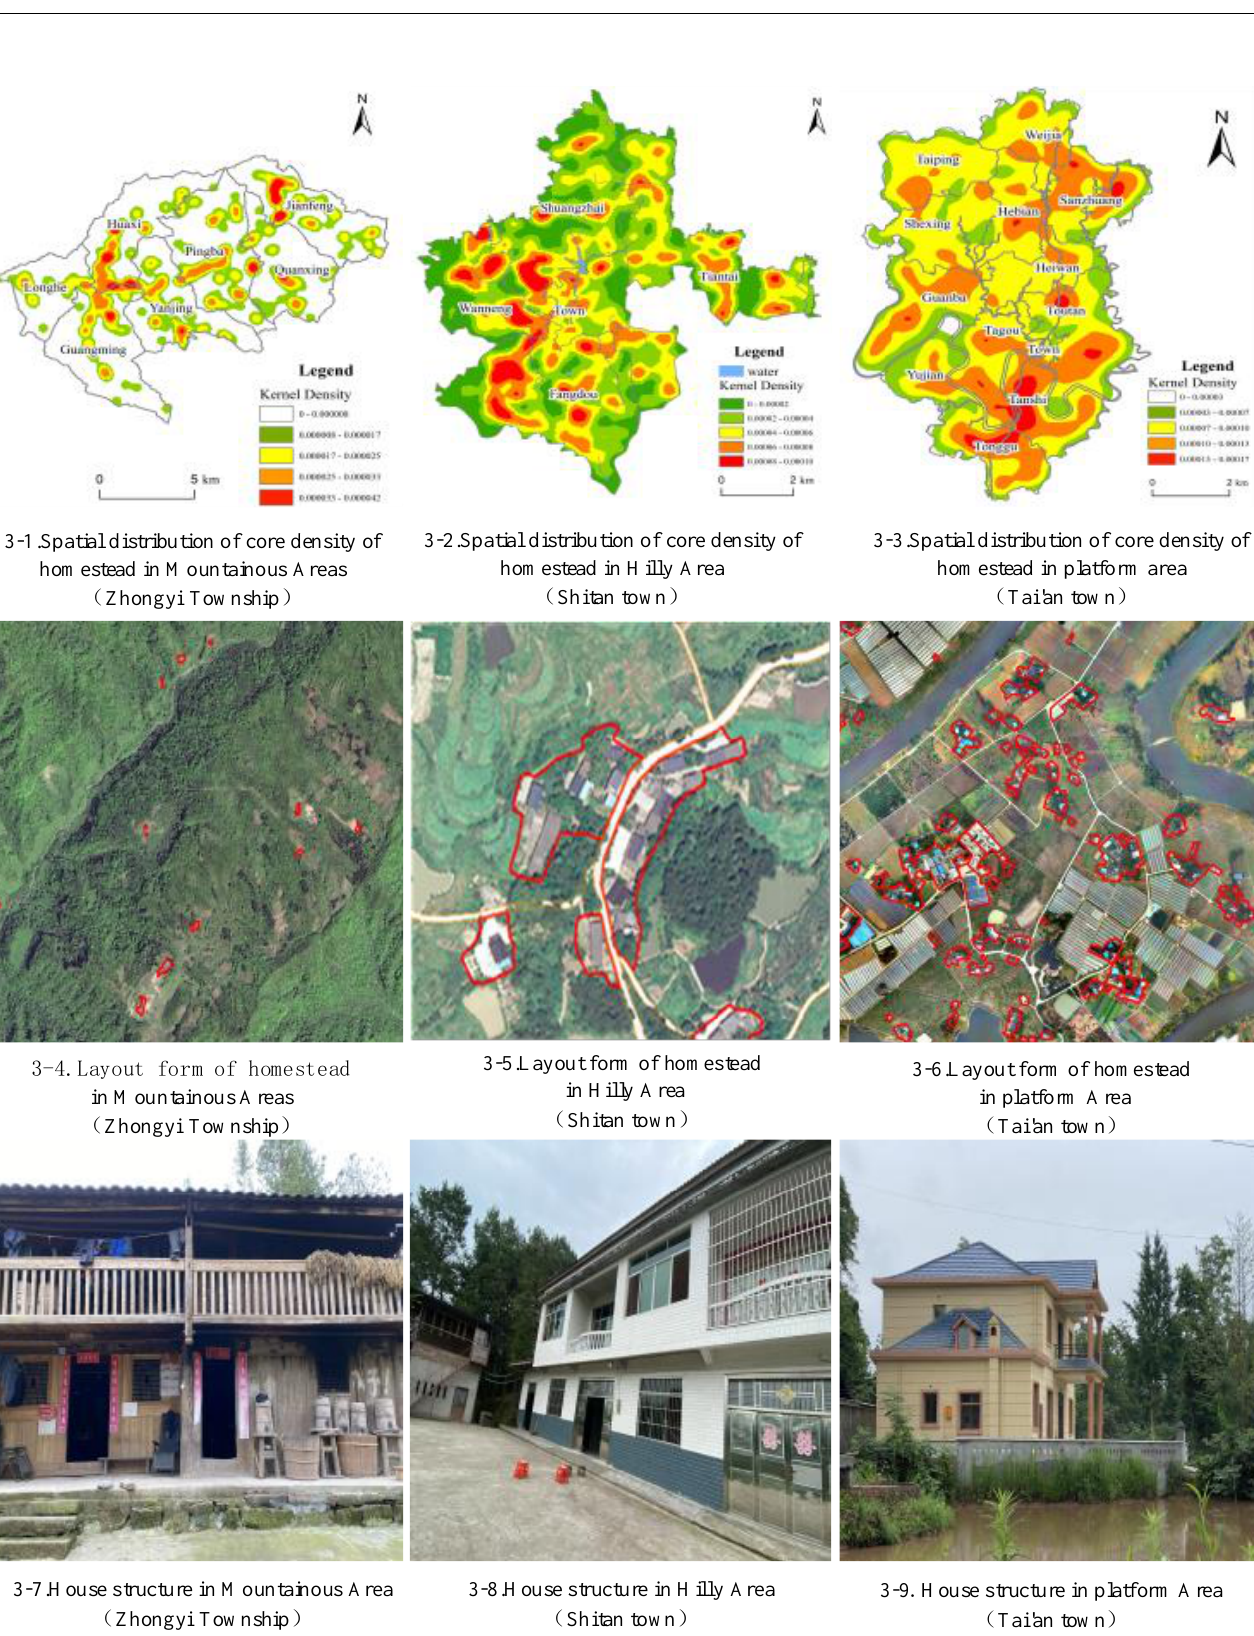
Figure 3. Characteristics of homestead features in different landscapes of Chongqing. Note: 3-1, 3-2 and 3-3 are nuclear density analysis diagrams of different geomorphic types; 3-4, 3-5 and 3-6 are layout form of homestead in different geomorphic types; 3-7, 3-8 and 3-9 are house structure in different geomorphic types.